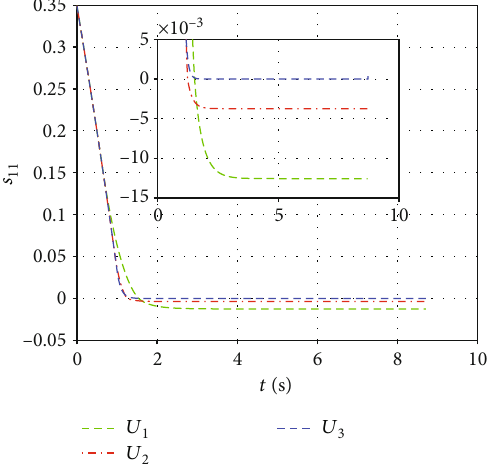
Figure 33: Dynamic error surfaces s